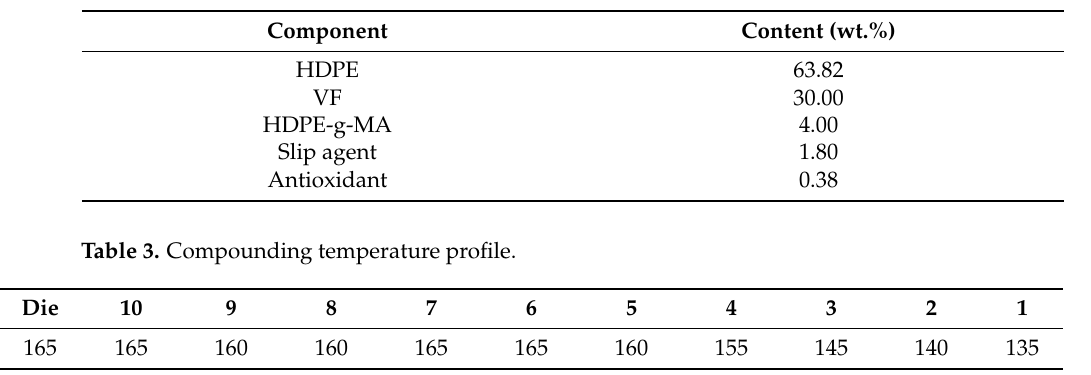
Table 2. Composition of samples.